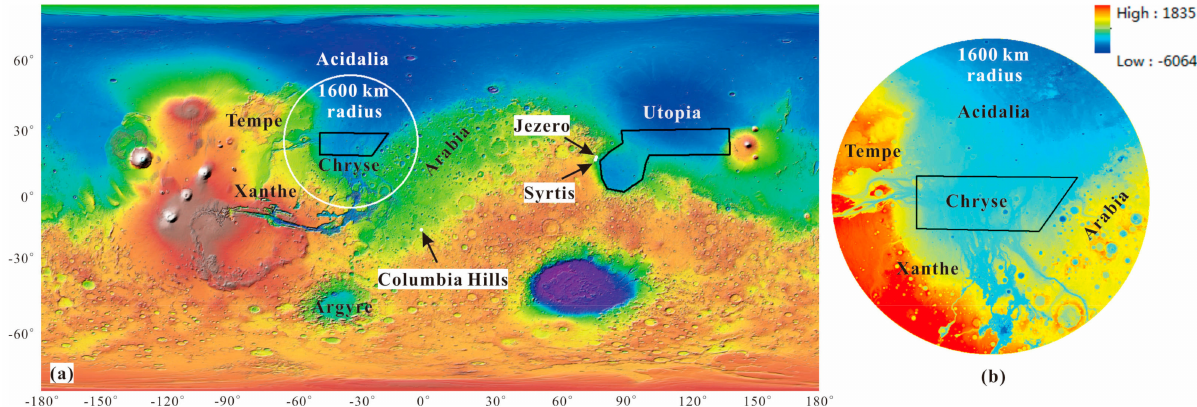
Figure 1. ( a ) Two tentative landing areas of Tianwen-1 mission on an elevation rendering map from Mars Global Surveyor (MGS) Mars Orbit Laser Altimeter (MOLA) DEM data with a simple cylindrical projection. The black polygons show the two tentative landing areas and the black arrows denote the NASA Mars 2020 candidate landing sites, respectively. The white circle is Chryse’s 1600 km-radius monitoring ring. ( b ) The elevation map within the 1600 km-radius monitoring ring of the Chryse landing